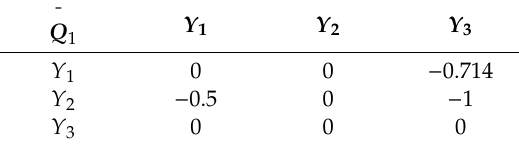
Table 10. The normalized regret matrix Q 1 .